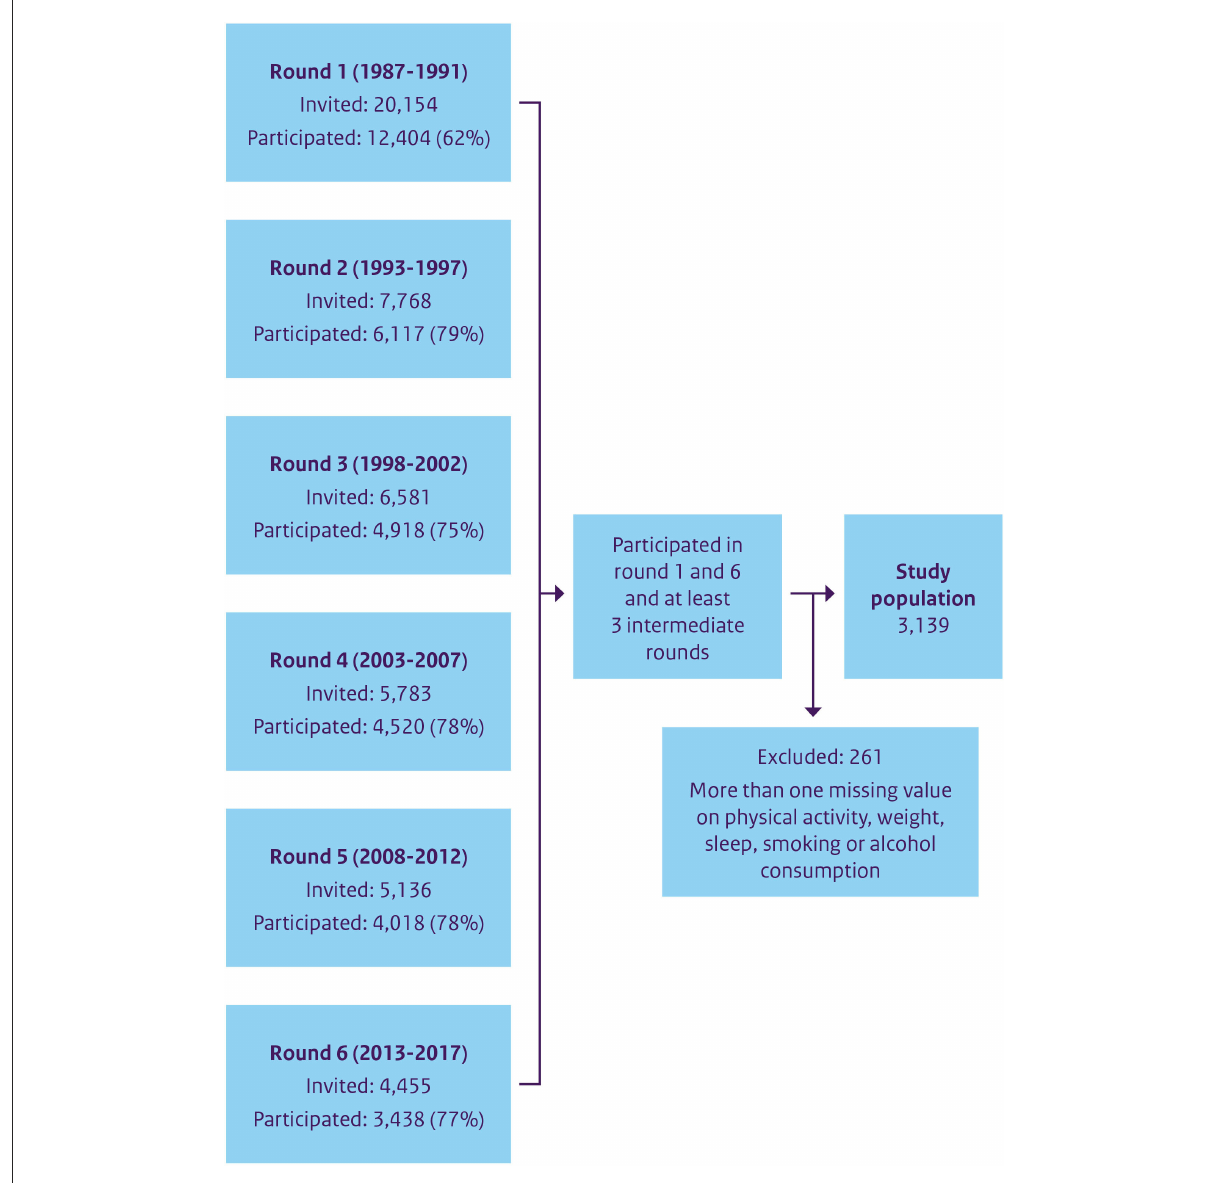
FIGURE1 Flowchart of the participants of the Doetinchem Cohort Study from round 1 till round